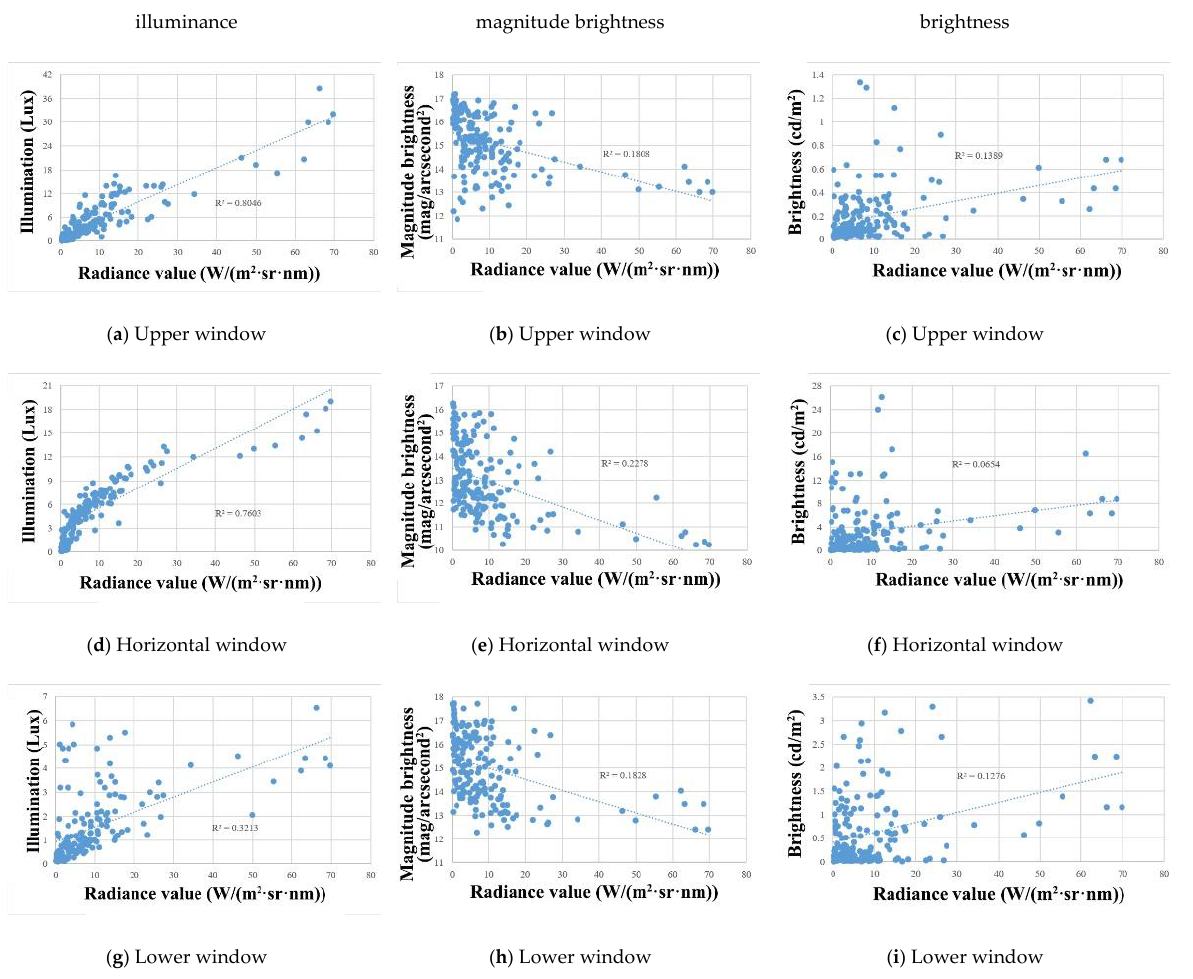
Figure 11. Fitting diagram of measured data and remote sensing data of illuminance of each win- dow.